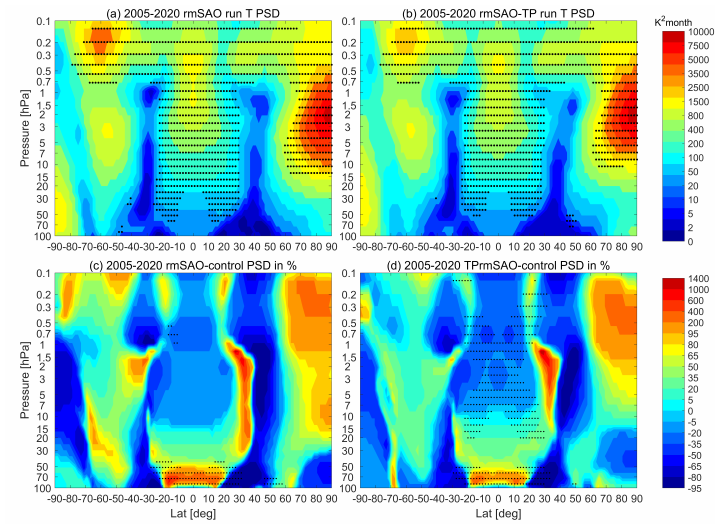
Figure 10. ( a ) The PSD of temperature SAO analyzed in the period 2005–2020 based on model simulation with removed SST-SAO (rmSAO). ( b ) Same as ( a ), but for the simulation with removed SST-SAO in the tropics (rmSAO-TP). The dots mark SAO significant areas with an FDR level of 0.05. ( c ) The relative difference of temperature SAO PSD between rmSAO and the control simulation (rmSAO-Control)/Control × 100 in the period 2005–2020. ( d ) Same as ( c ), but for the relative difference between rmSAO-TP and the control simulation (rmSAO-TP-Control)/Control × 100. The differences in the simulation energy budget are shown in Figures 11 and